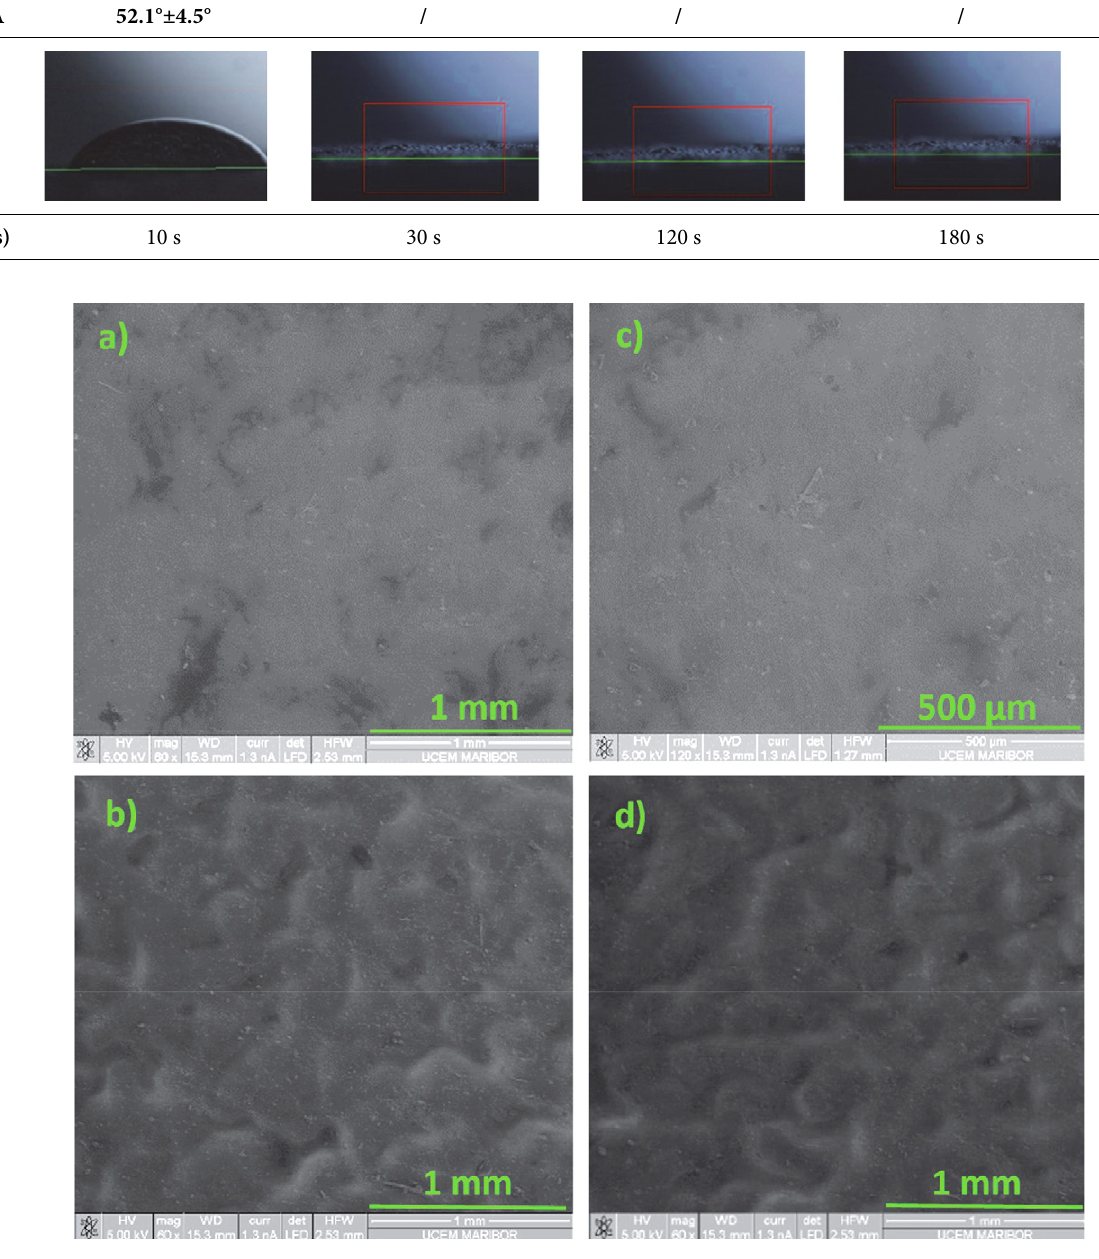
Table 5 : Time-dependent contact angles of water droplets on naturally aged and damaged plasticized PVC membranes (location 3) .